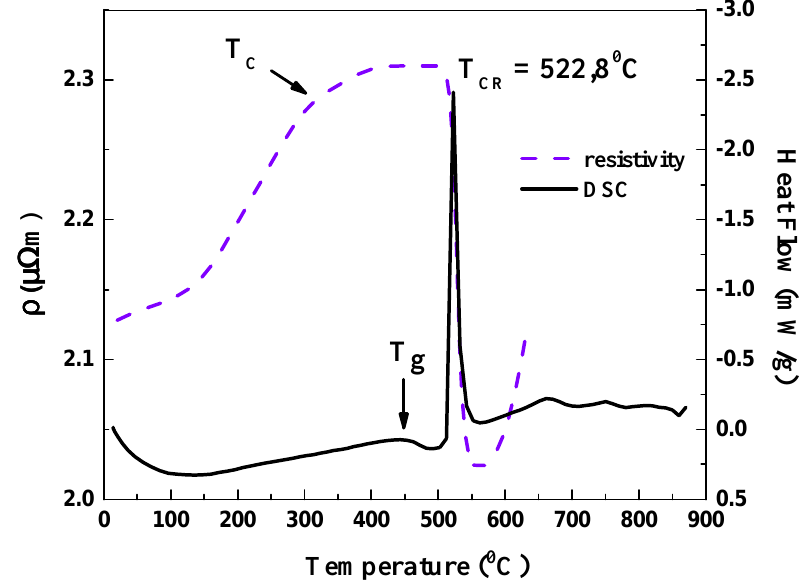
Figure 1. The temperature dependence of electrical resistivity and DSC thermogram (heating rate of 20 ºC/min) of the Fe